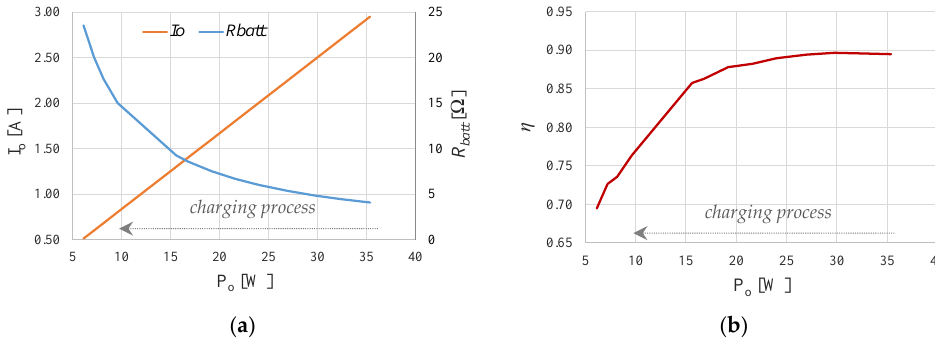
Figure 29. Experimental measurements obtained during the battery charging test: ( a ) PR-IPTS output current I o (orange) and battery static resistance R batt (blue) and ( b ) efficiency (red), vs. average output power P o .